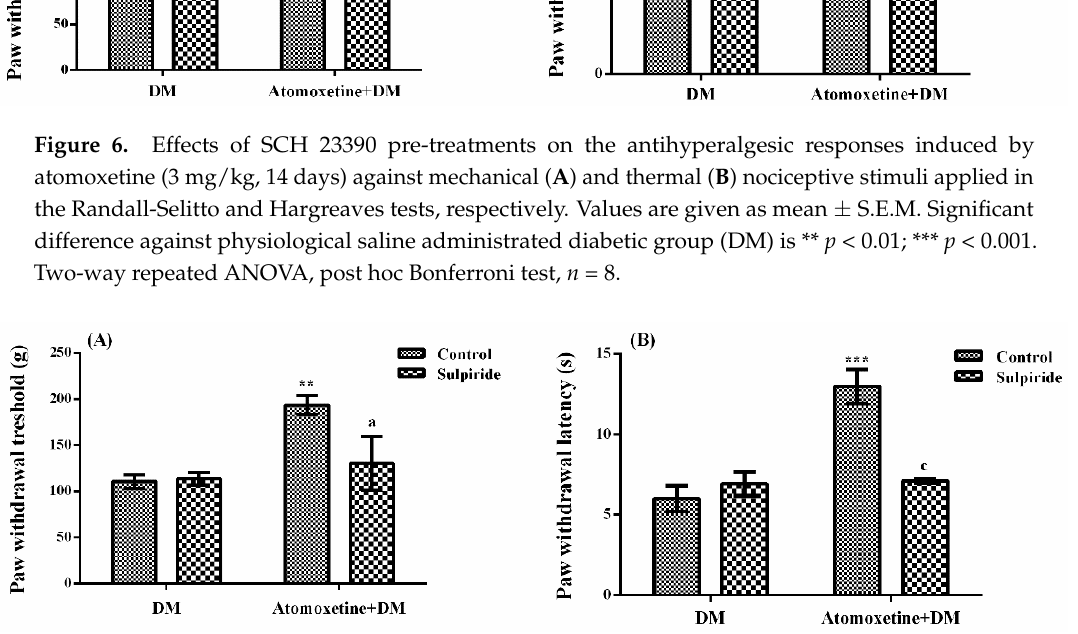
Figure 7. Effects of sulpiride pre-treatments on the antihyperalgesic responses induced by atomoxetine (3 mg/kg, 14 days) against mechanical ( A ) and thermal ( B ) nociceptive stimuli applied in the Randall-Selitto and Hargreaves tests, respectively. Values are given as mean ± S.E.M. Significant difference against physiological saline administrated diabetic group (DM) is ** p < 0.01; *** p < 0.001; Significant difference against atomoxetine administrated diabetic groups (Atomoxetine+DM) are a p < 0.05 and c p < 0.001. Two-way repeated ANOVA, post hoc Bonferroni test, n = 8.